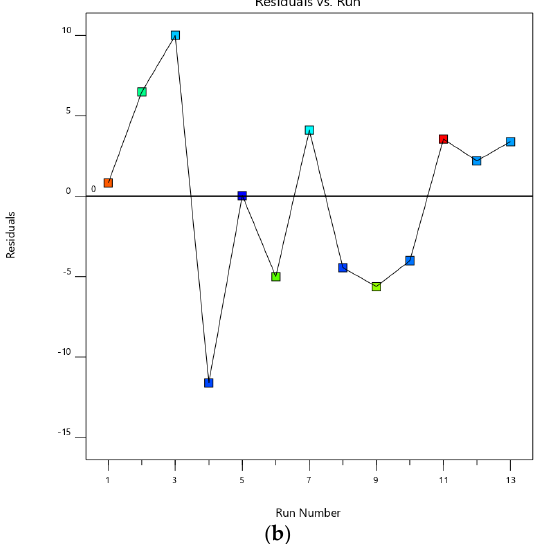
Figure 2. The plot between actual and predicted values ( a ) and the plot between residual and run ( b ).